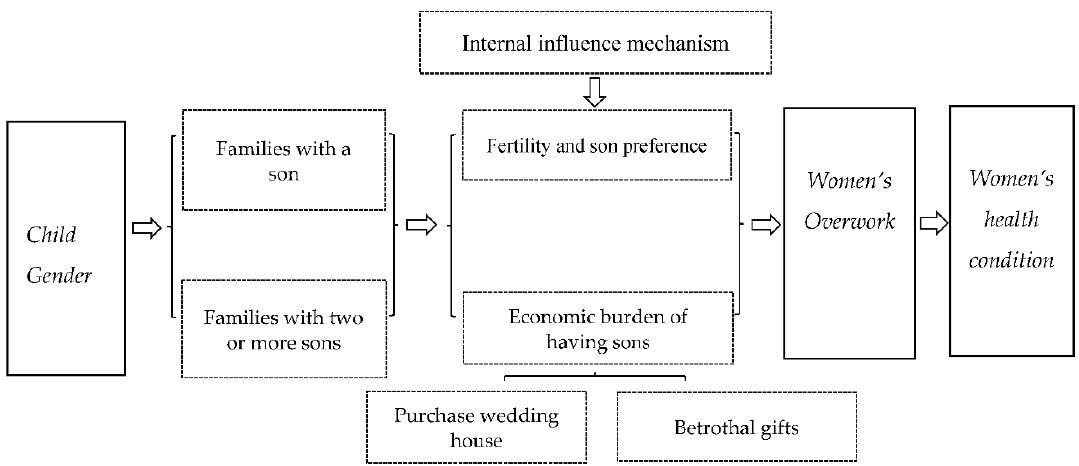
Figure 1. The theoretical framework of child gender and migrant women’s overwork in China.